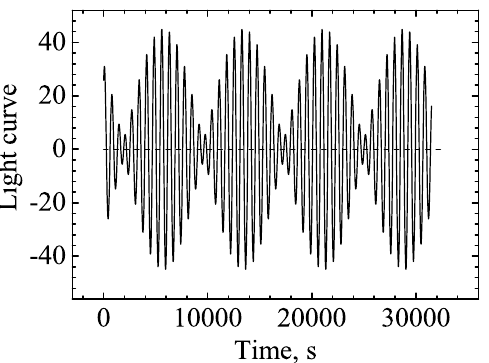
Fig. 5. Synthetic light curve, calculated as the function: lc = 20 sin 2 πt · 0 . 00130+ 25 cos 2 πt · 0 . 00143